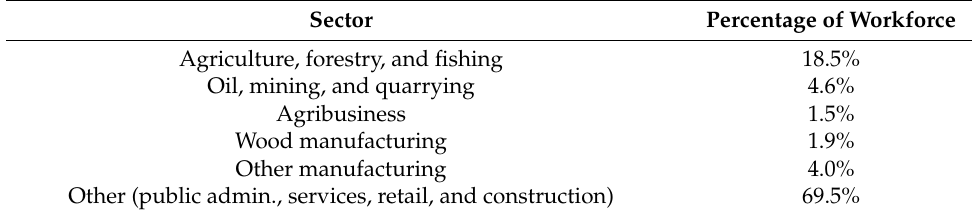
Table 3. Formal employment by sector in Gabon 2017 *. Sector Percentage of Workforce Agriculture, forestry, and fishing 18.5% Oil, mining, and quarrying 4.6% Wood